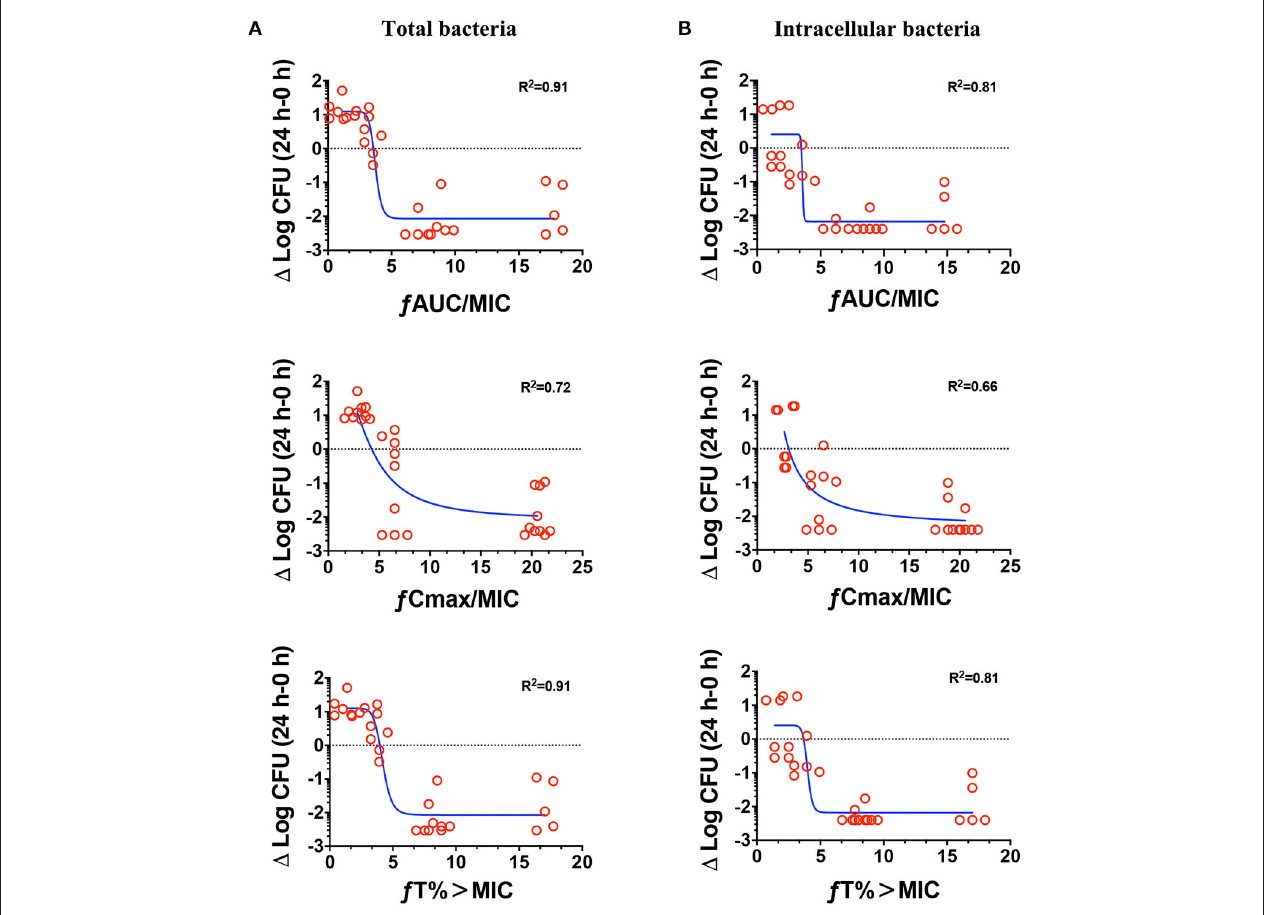
FIGURE 6 | Pharmacokinetics and pharmacodynamics index determination. Correlations between the pharmacokinetic parameters (24h ê AUC/MIC, ê C max /MIC, and ê T% > MIC) and efficacies for total bacteria (A) and intracellular activity (B) over 24h against S. aureus E48 (MIC = 1 µ g/ml) in the mouse peritonitis model. The ordinate indicated the total bacteria and intracellular bacteria counts change in peritoneal lavage fluids between the treated for 24h animals and those at the start of therapy. Each symbol indicates the bacteria of each mouse. The curves indicate the best fit using the sigmoid E max model. R 2 value represents the magnitude of correlation.